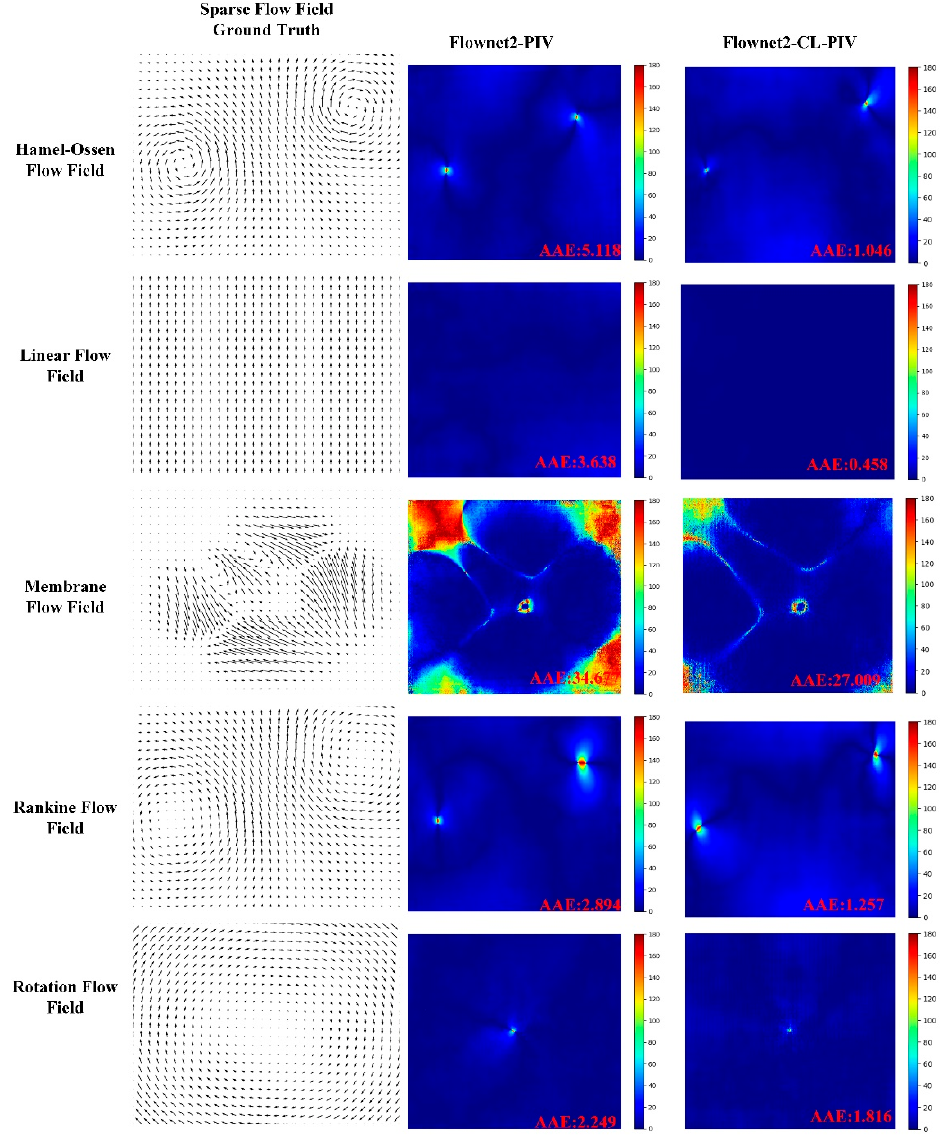
Figure 6. AAE results of two methods on different flow fields.